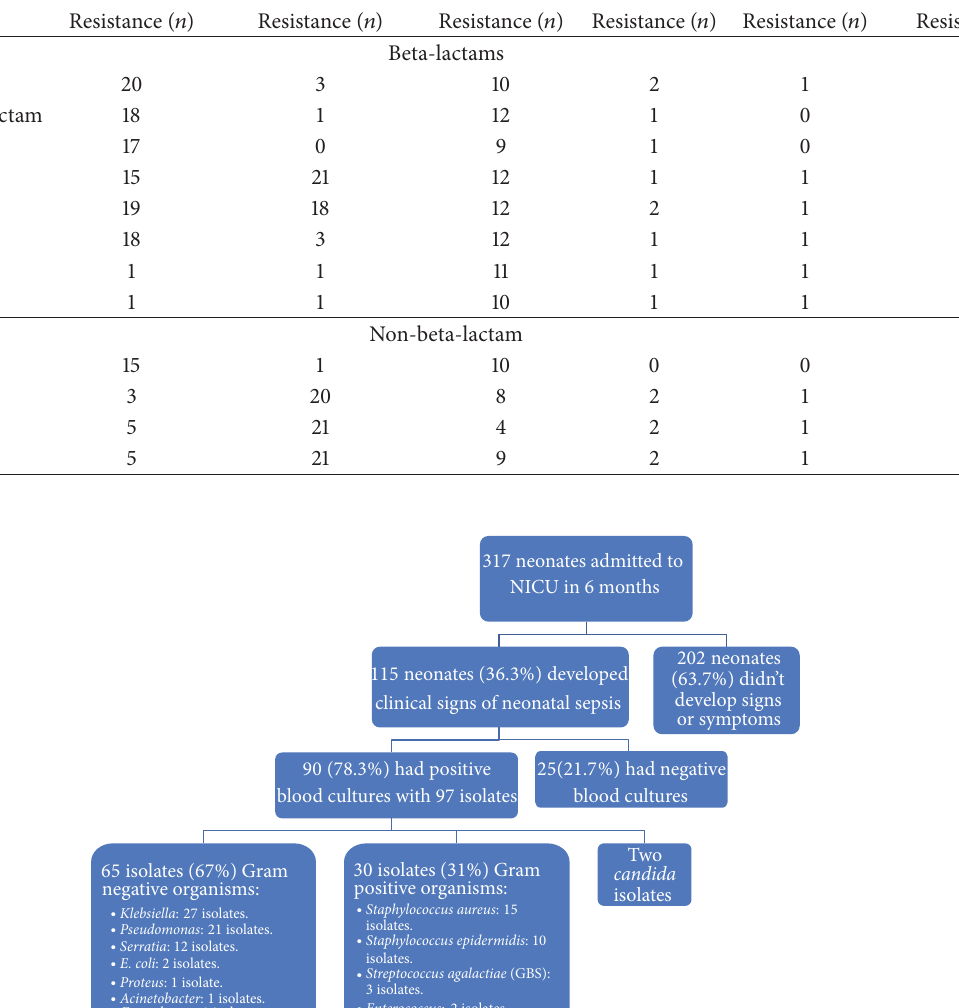
Table 3: Antibiotic sensitivity of Gram negative organisms. Klebsiella ( 𝑛 : 27)